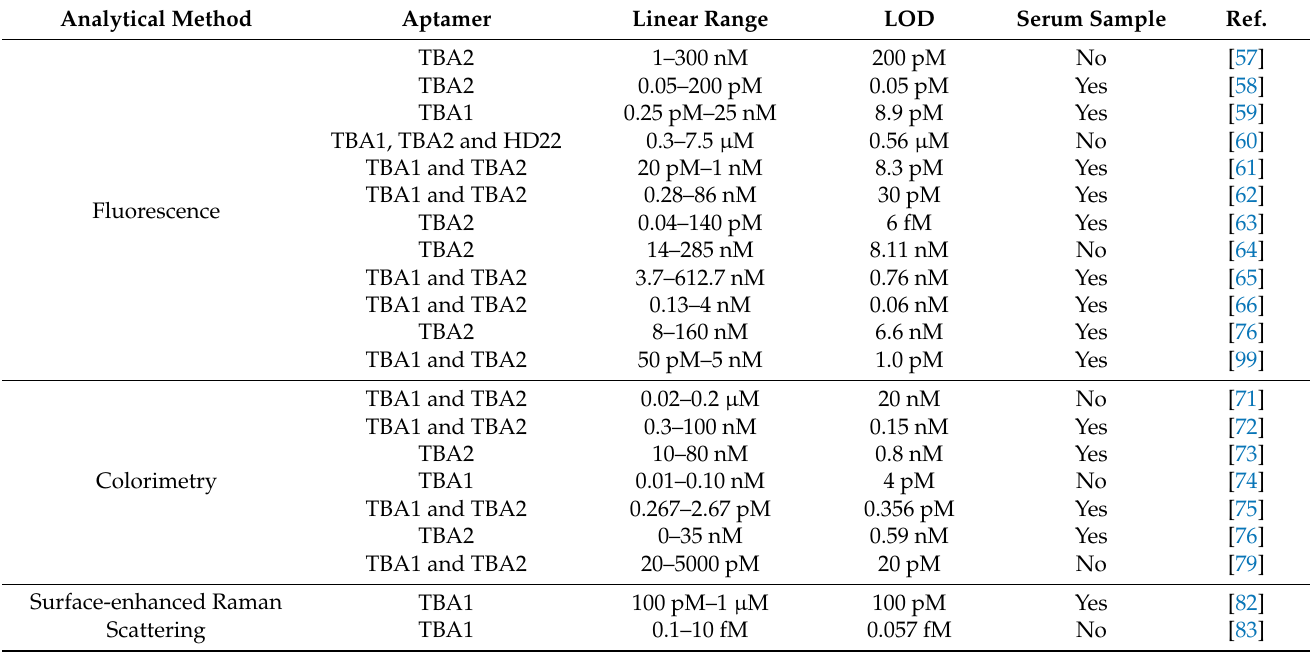
Table 1. Summary of aptamer-based sensors for thrombin